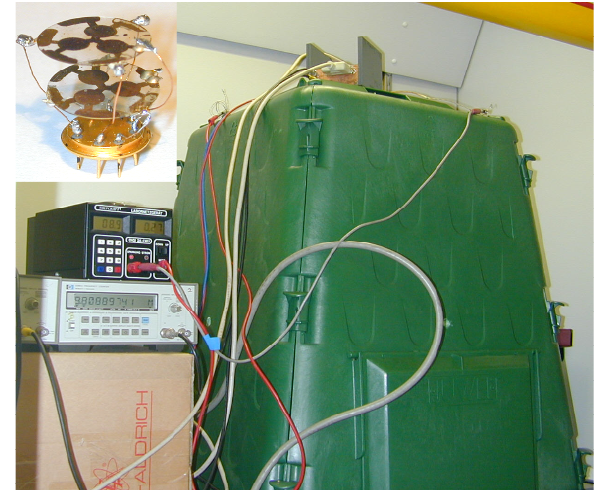
Figure 3: Composter and sensor array used selectivities followed by multivariate data analysis leads to reliable sensor results. We demonstrated this principle by mounting a QCM containing six electrode pairs in the headspace of a small composter and monitoring the concentrations of four predefined key-analytes, namely small aliphatic alcohols, ethyl acetate, limonene and humidity. Each of these compounds can be used as a lead analyte characterizing a different stage of plant degradation.